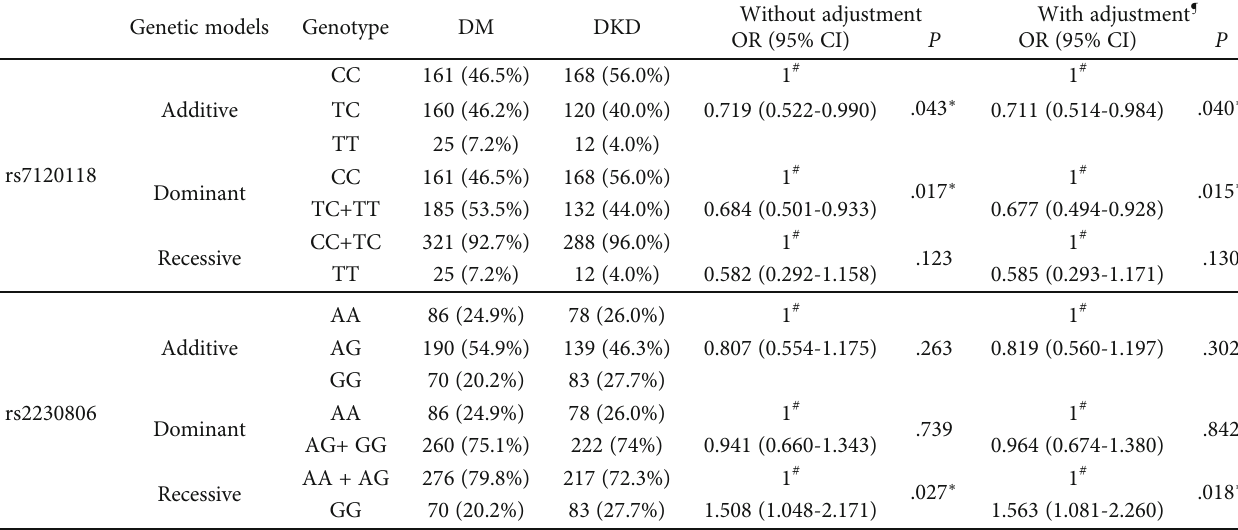
Table 3: Genetic model analyses of the association between the SNPs and DKD with adjustment for age and gender. Genetic models